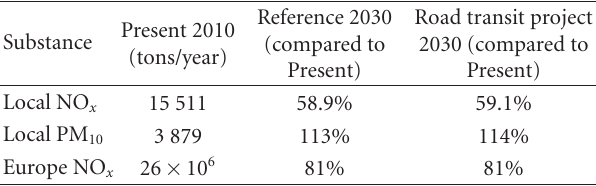
Table 1: Local (2 × 2km 2 grid over Stockholm) and European emissions for present situation (year 2010) and for two alternative future (year 2030)